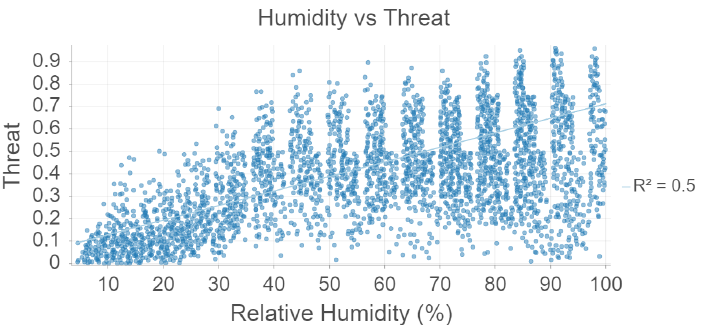
Figure 4. Humidity and Threat analysis using Random Forest.